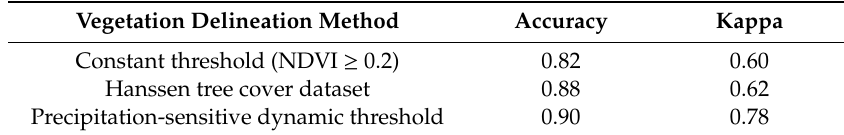
Table 1. Comparison of the validation results of the proposed precipitation-sensitive dynamic threshold method compared to two alternative methods.